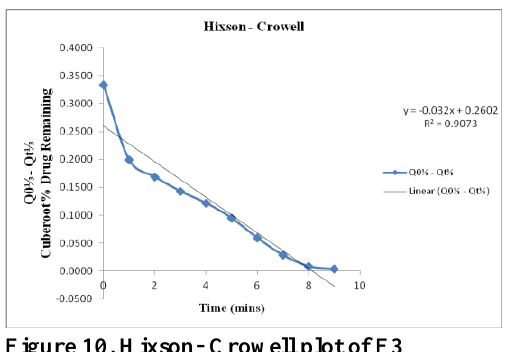
Figure 10. Hixson- Crowell plot of F3